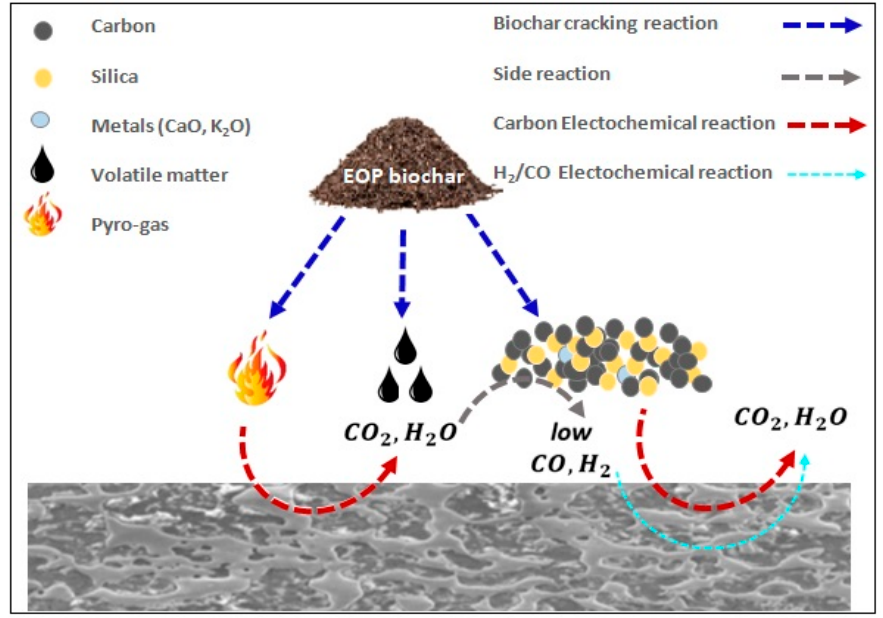
Figure 12. Presentation of the anodic reaction mechanisms of the EOPbiochar as a fuel in the DCFC.